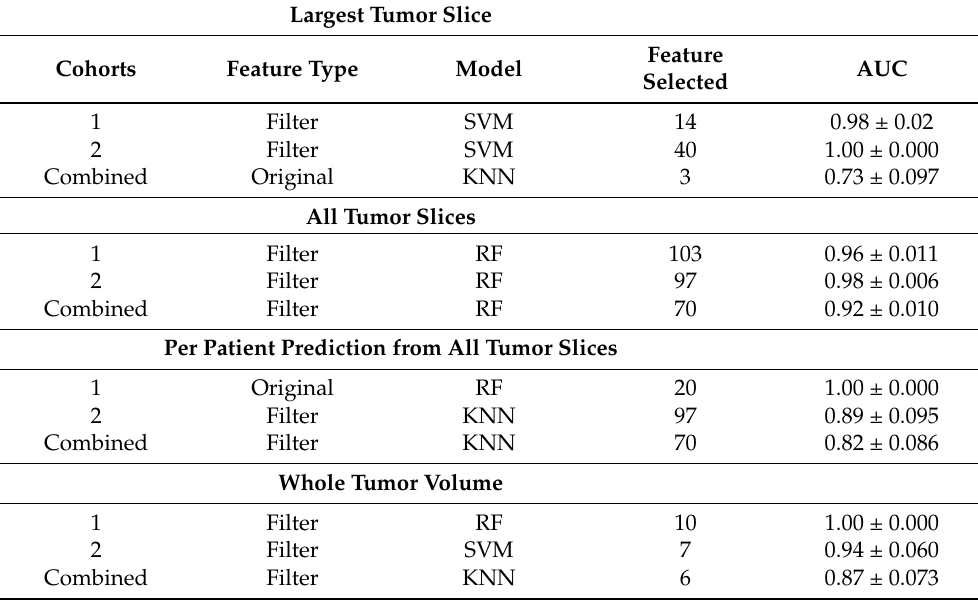
Table 11. Summary of best diagnostic performance. The table displays the best AUCs from the different categories and